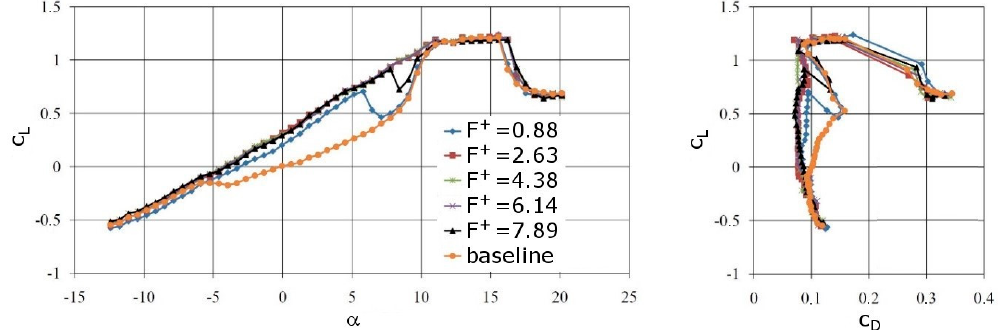
Figure 31. Lift curve and drag polar for Re = 64,200. Plasma actuator at 40% chord. (Reprinted from [29]).